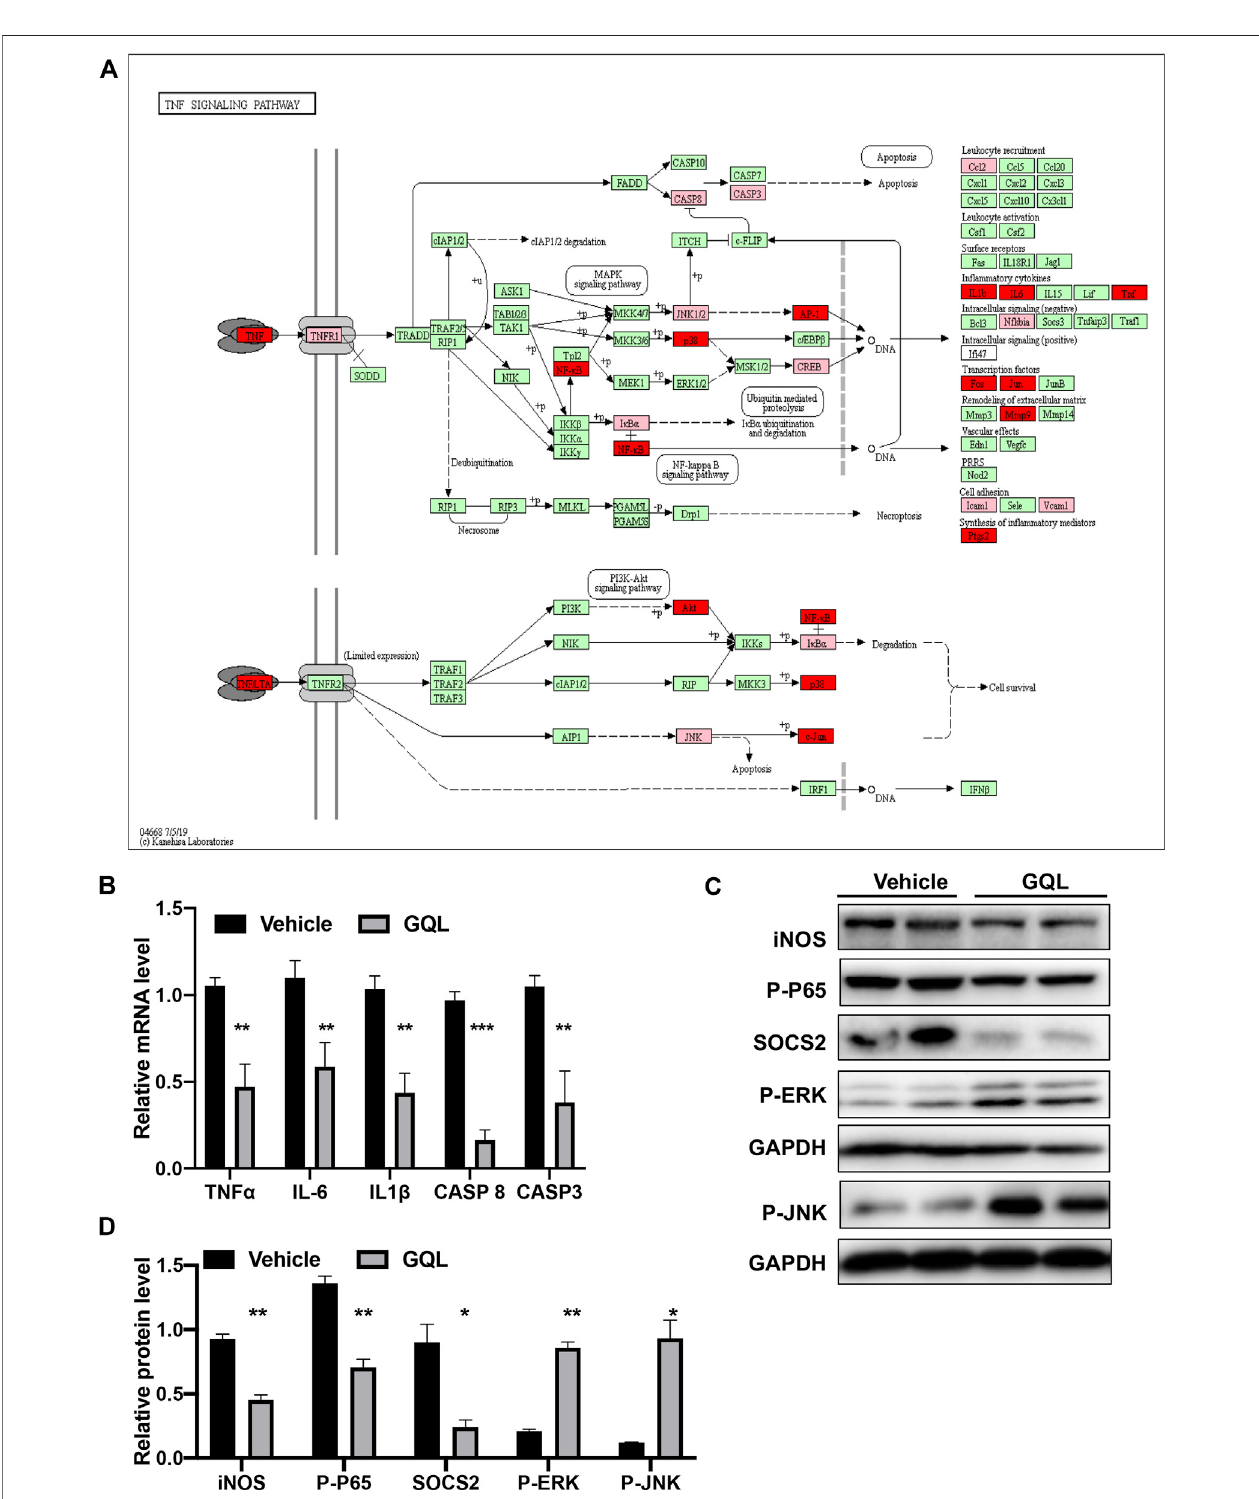
FIGURE 7 | (A) KEGG pathway map of the TNF α signaling pathway; (B) levels of TNF α , IKK α , IL-6, IL1 β , CASP 8, CASP3, and AP-1 mRNA determined using RT- PCR; (C,D) relative expression of iNOS, P-P65, SOCS2, P-JNK, and P-ERK as detected by immunoblotting.